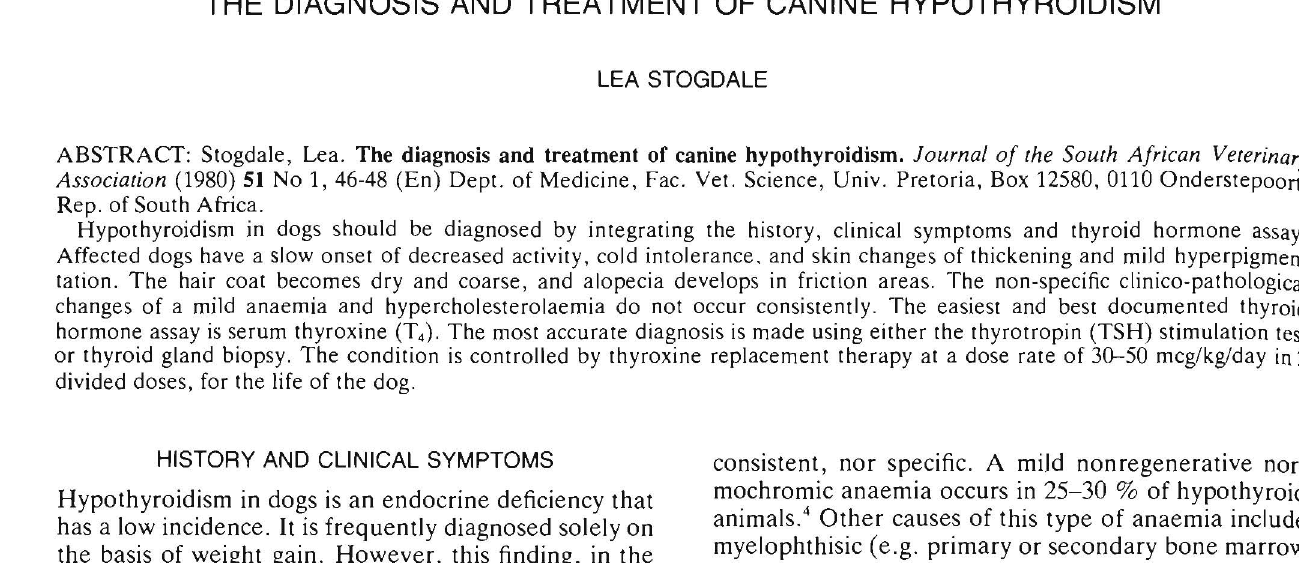
Table 1: NORMAL CHOLESTEROL VALUES ACCEPTED BY OUR LABORATORY Animal and diet